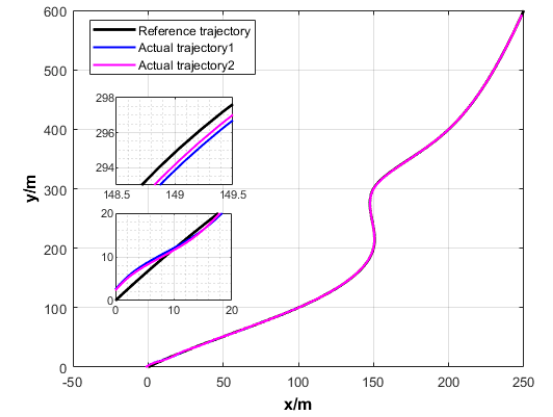
Figure 10. Curved path tracking of USV under two strategies.